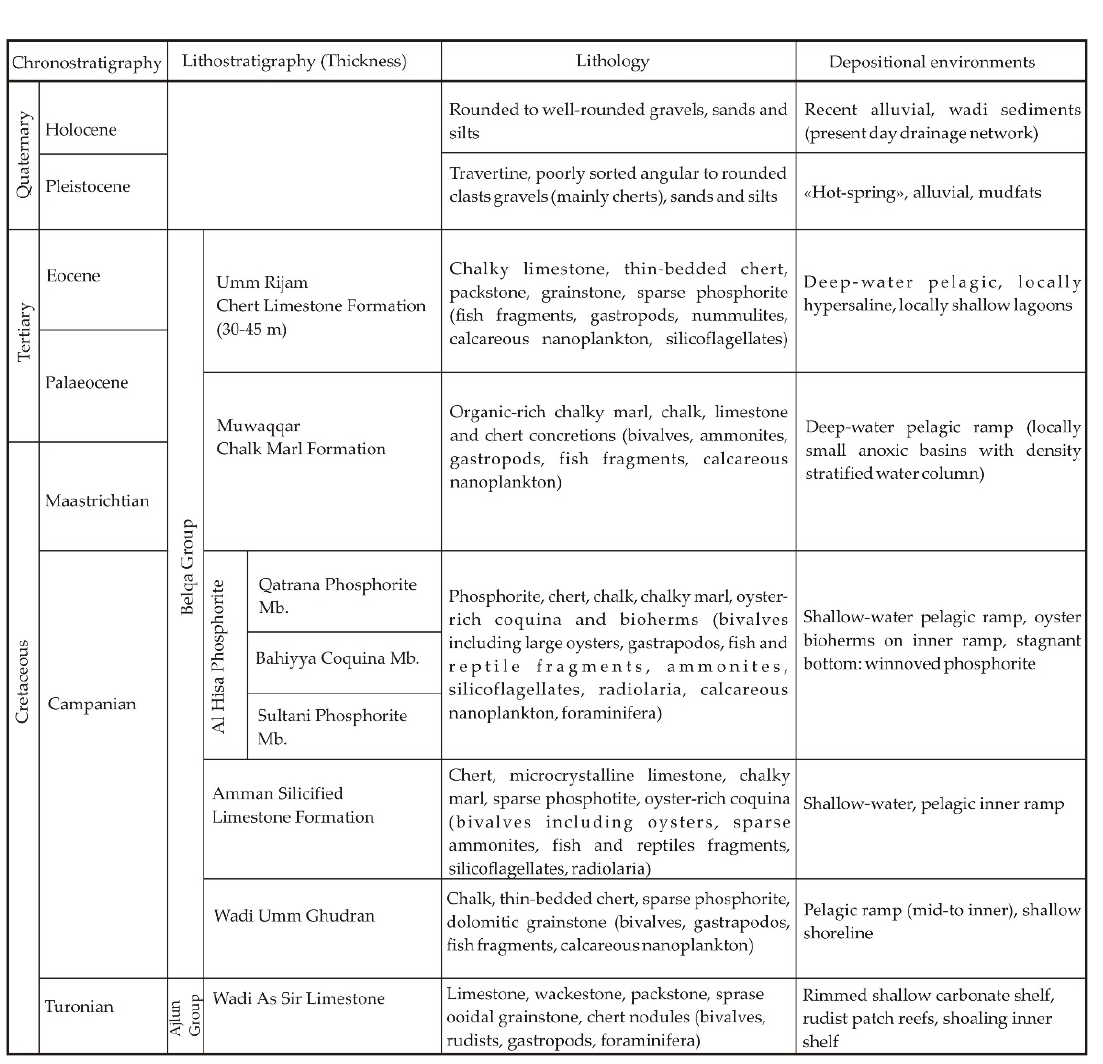
Figure 2. Synthesised stratigraphic nomenclature: lithostratigraphy and lithology of central Jordan. Compiled data from [4,31]. Mb. = Member.